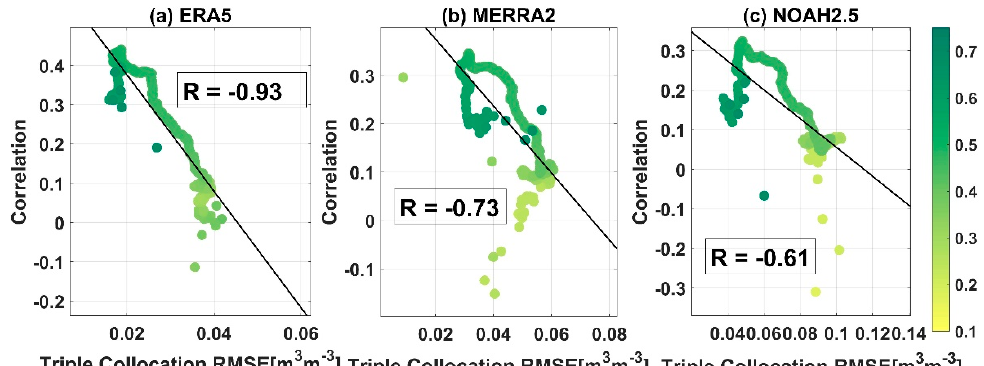
Figure 6. A direct comparison between the correlation and triple collocation analyses of ( a ) ERA5, ( b ) MERRA2 and ( c ) NOAH by matching TC RMSEs over the in situ locations. The colors correspond to vegetation densities over the region.